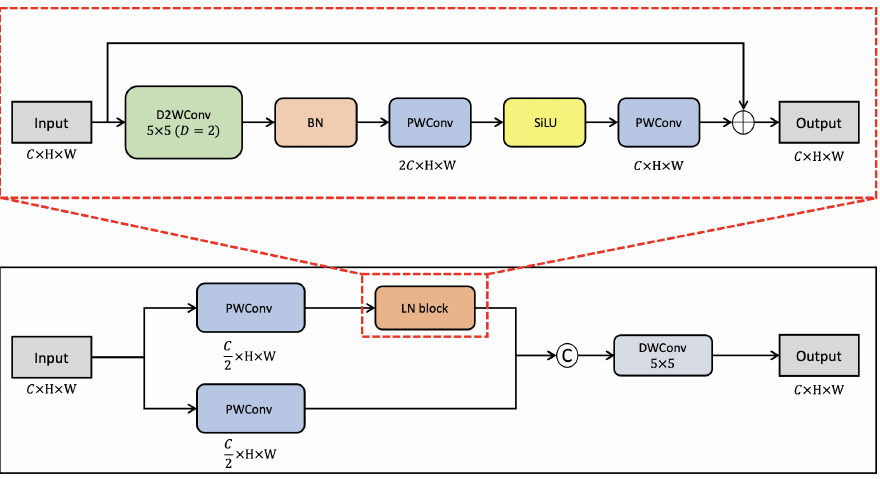
Figure 5. Structure of light next block. The proposed LNblock enables the efficient extraction of spatial information with low computational cost. Here, D2WConv, BN, PWConv, and SilU are the dilated depth-wise convolution, batch norm, 1 × 1 convolution, and sigmoid linear unit activation function,